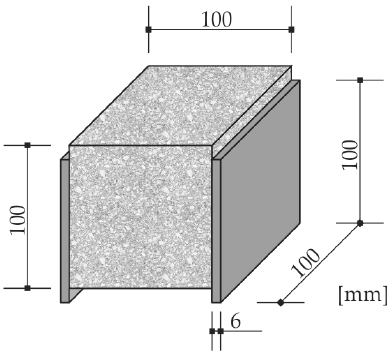
Figure 1. Geometry of push-out specimen.